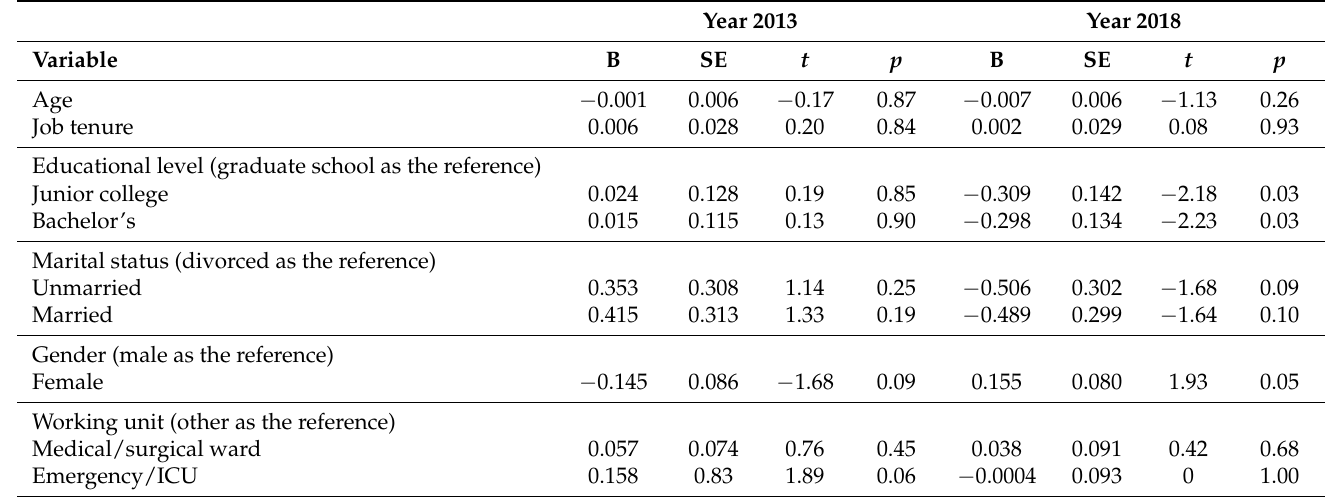
Table 2. Predictive variables of knowledge of palliative care in 2013 and 2018.